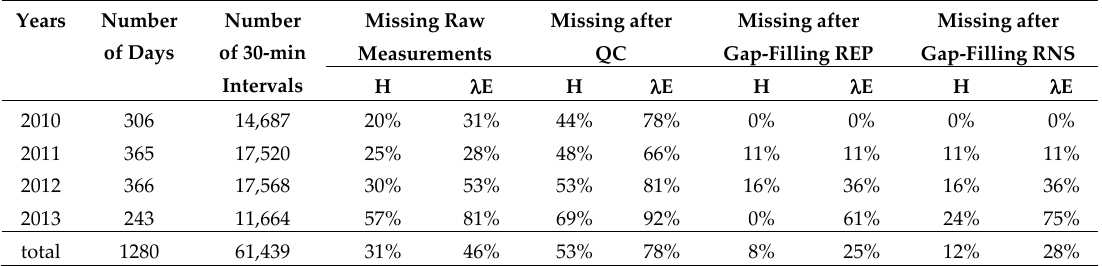
Table 1. Summary of the available flux data available, for the sensible (H) and latent ( λ E) heat fluxes. The number of 30-min intervals correspond to the number of days of the experiment. The rates of missing data are given as percentages of the number of 30-min intervals. Missing raw measurements are due to experimental failures. Missing after QC correspond to the sum of missing raw measurements and data eliminated by quality control (Section 2.3.2). Missing data after gap-filling are given for both way of applying REddyProc: without separating the wind directions (REP), and after separating the wind directions (RNS, see Section